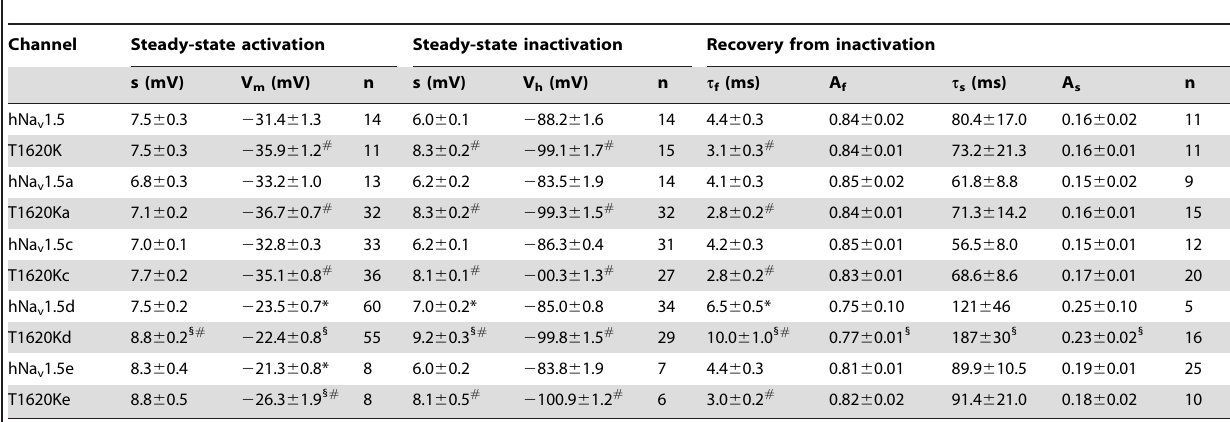
*Indicates p , 0.05 for a hNa v 1.5 splice variant versus hNa v 1.5, illustrating alterations caused by alternative splicing of hNa v 1.5. 1 Indicates p , 0.05 for a spliced T1620K variant versus T1620K, illustrating alterations caused by alternative splicing of T1620K. # Indicates p , 0.05 for a T1620K variant versus the corresponding hNa v 1.5 variant, illustrating alterations caused by the T1620K mutation only.